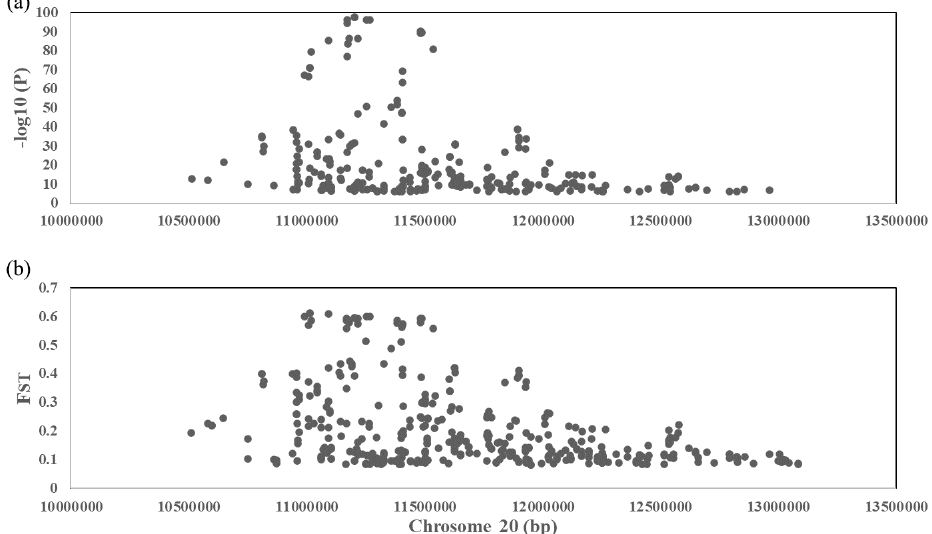
Figure 4. (a) A scatterplot presenting all the significant ( − log10( P ) > 6) single-nucleotide polymorphisms (SNPs) GWAS tested on chromo- some 20 for the comb color phenotype. (b) A scatterplot presenting all the significant (top 0.1%) single-nucleotide polymorphisms (SNPs) F ST tested on chromosome 20 for the comb color